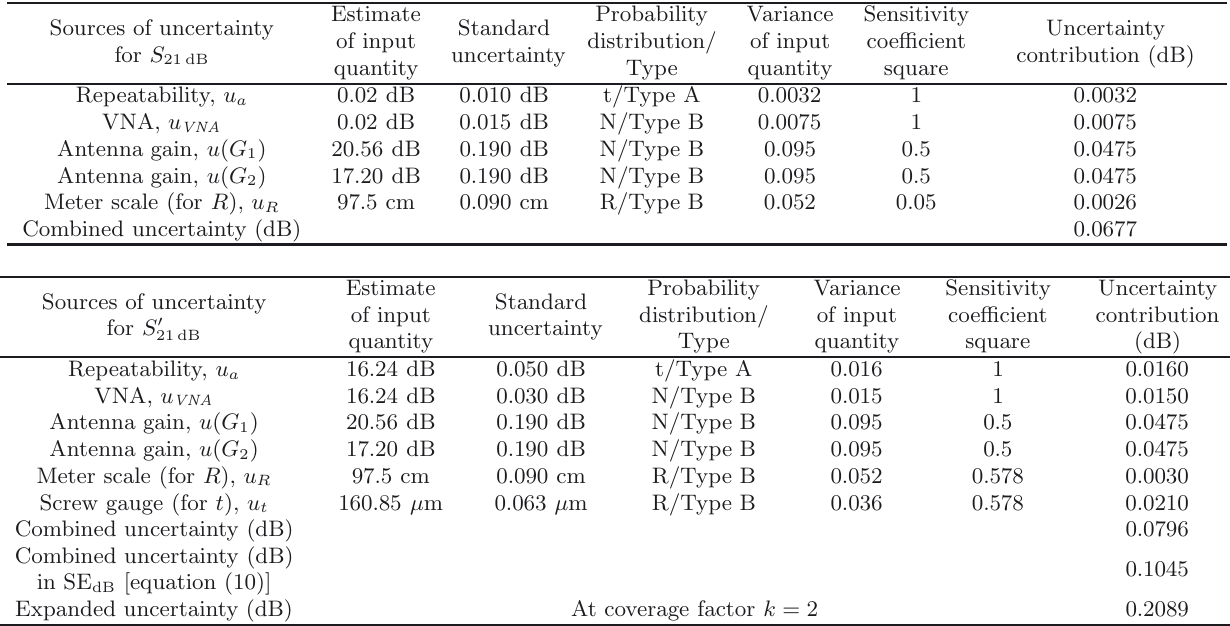
Fig. 3. A traceability link established for SE measurements. Table 4. Uncertainty budget for sample III at 11